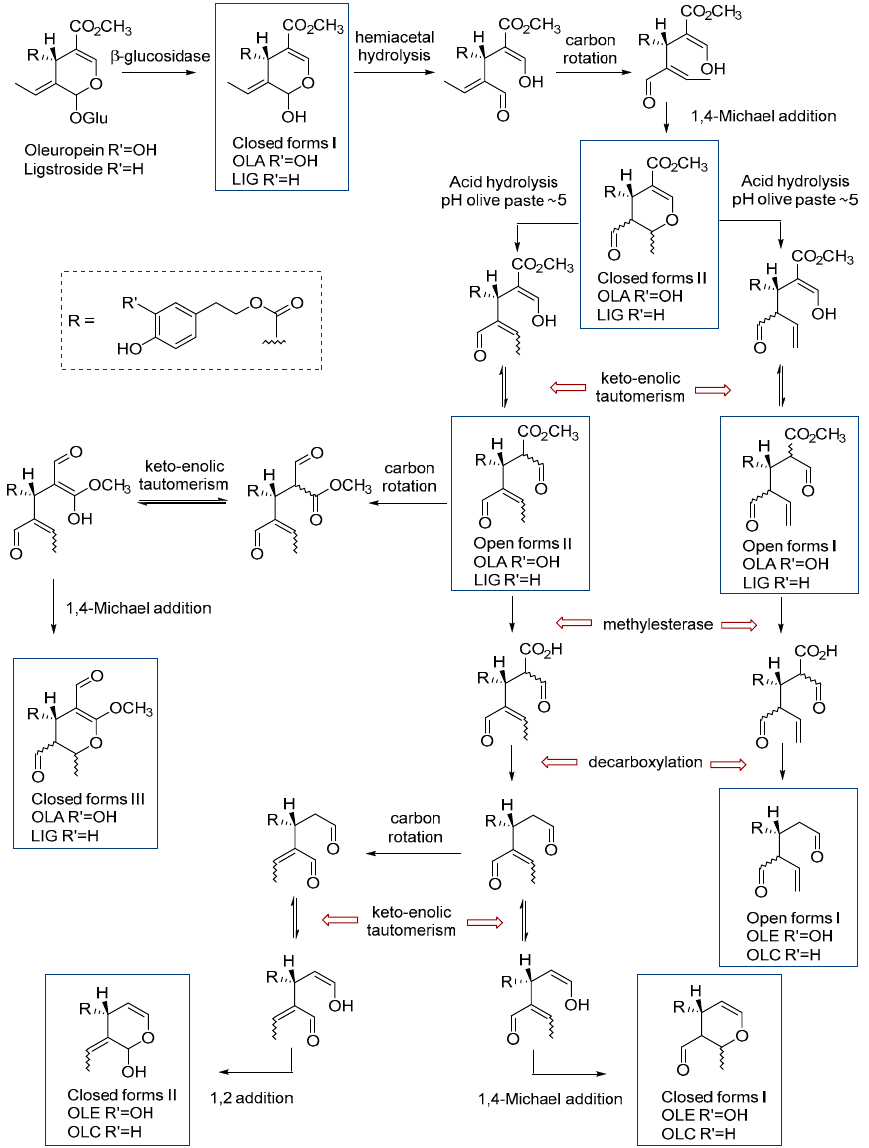
Figure 1. Conversion of Oleuropein and Ligstroside to oleuropein aglycone (OLA), oleacein (OLE), ligstroside aglycone (LIG), and oleocanthal (OLC) during oil extraction. Adapted from Abbattista et al., 2019 [10] and adding the closed forms I and II for OLC and OLE, which are possible artifacts. Those phenolic compounds are the responsible of some EVOO health effects